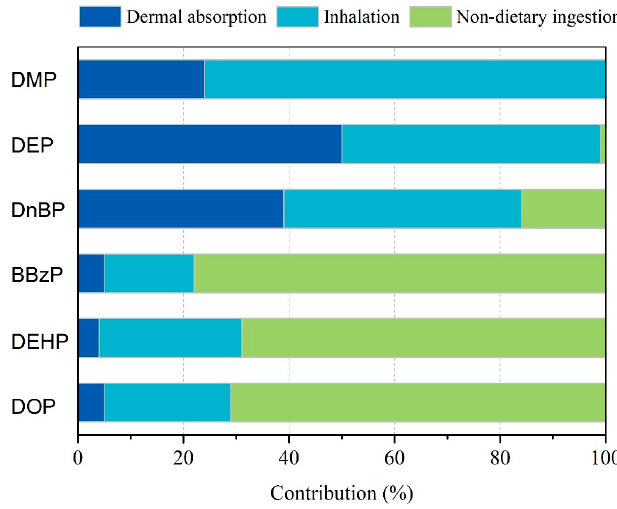
Figure 2. Mean contributions of exposure pathways for each phthalate.